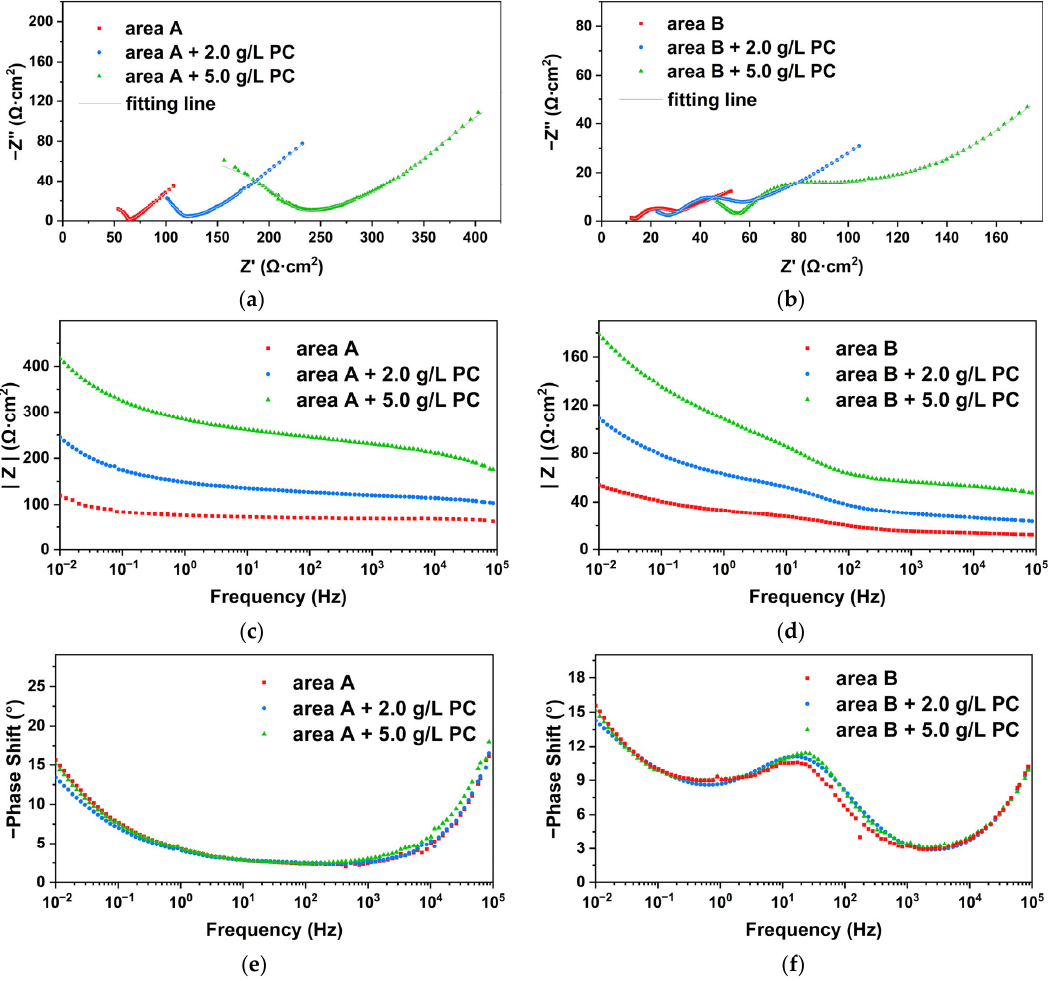
Figure 15. EIS plots of original and proanthocyanidins ‐ treated archaeological steel in area A and B. Nyquist plots ( a , b ); |Z| vs. frequency in Bode plots ( c , d ); θ vs. frequency in Bode plots ( e , f ).